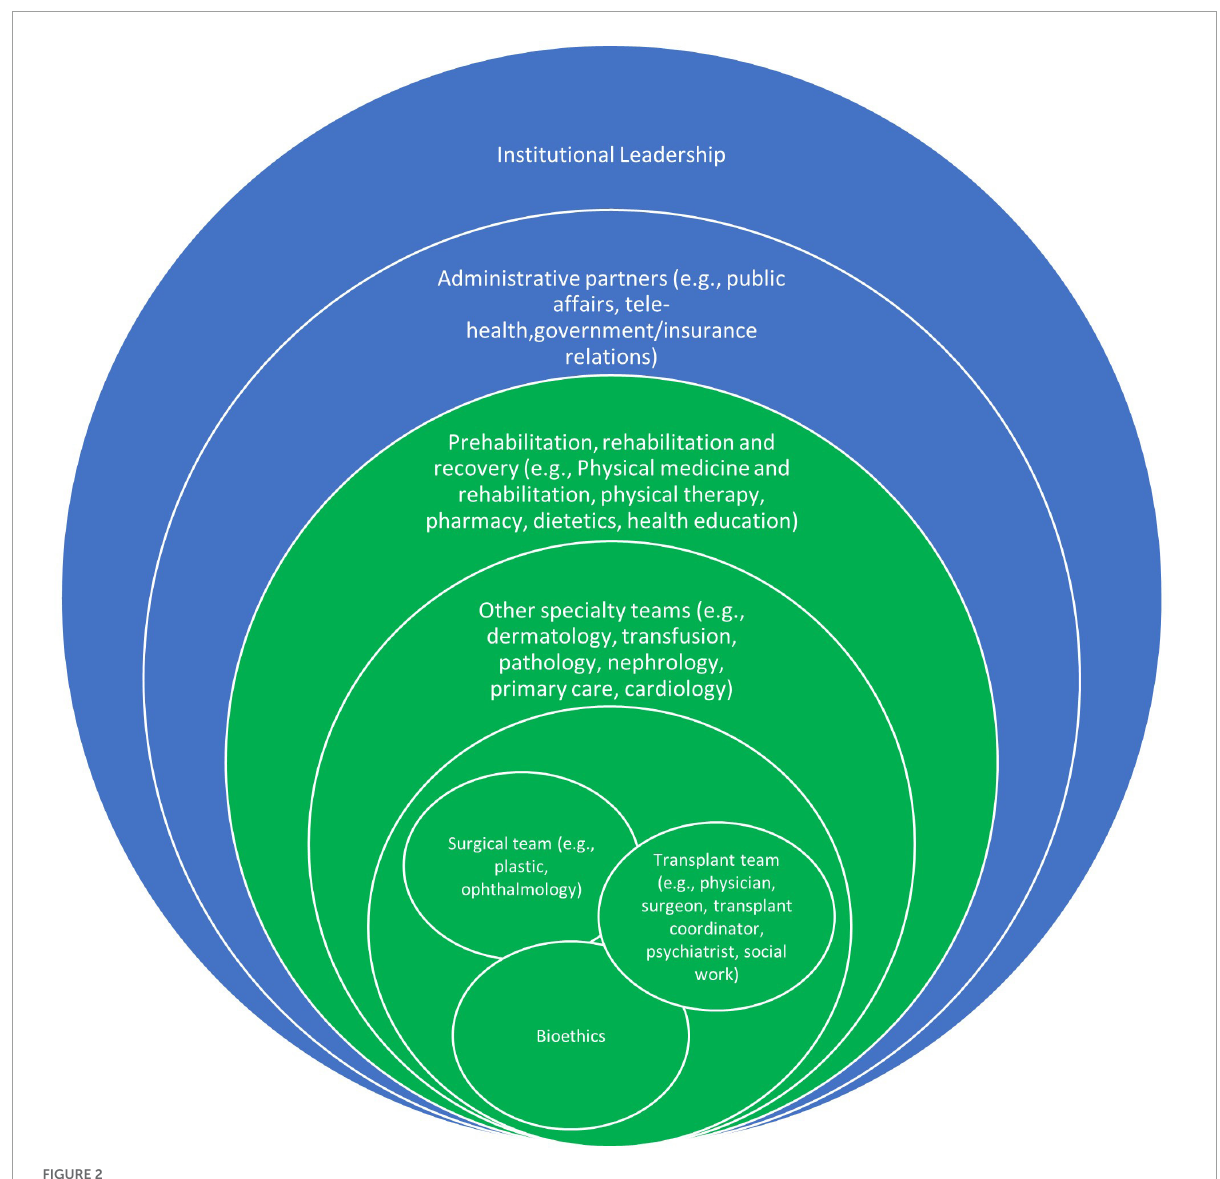
FIGURE2 VCA team